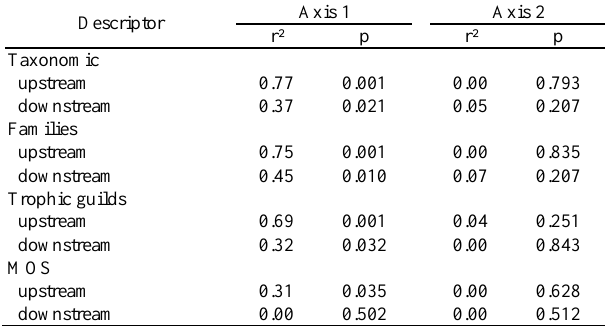
Table 4. Results of the correlations between the coordinates of samples on the axes of the Correspondence Analysis (CA) and the corresponding water levels (n = 12 in every case).